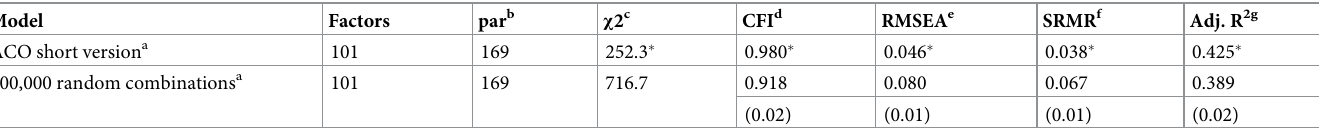
Table 3. Model fit indices and external validity for the ant colony optimised short version compared to 100,000 random combinations of items. Model